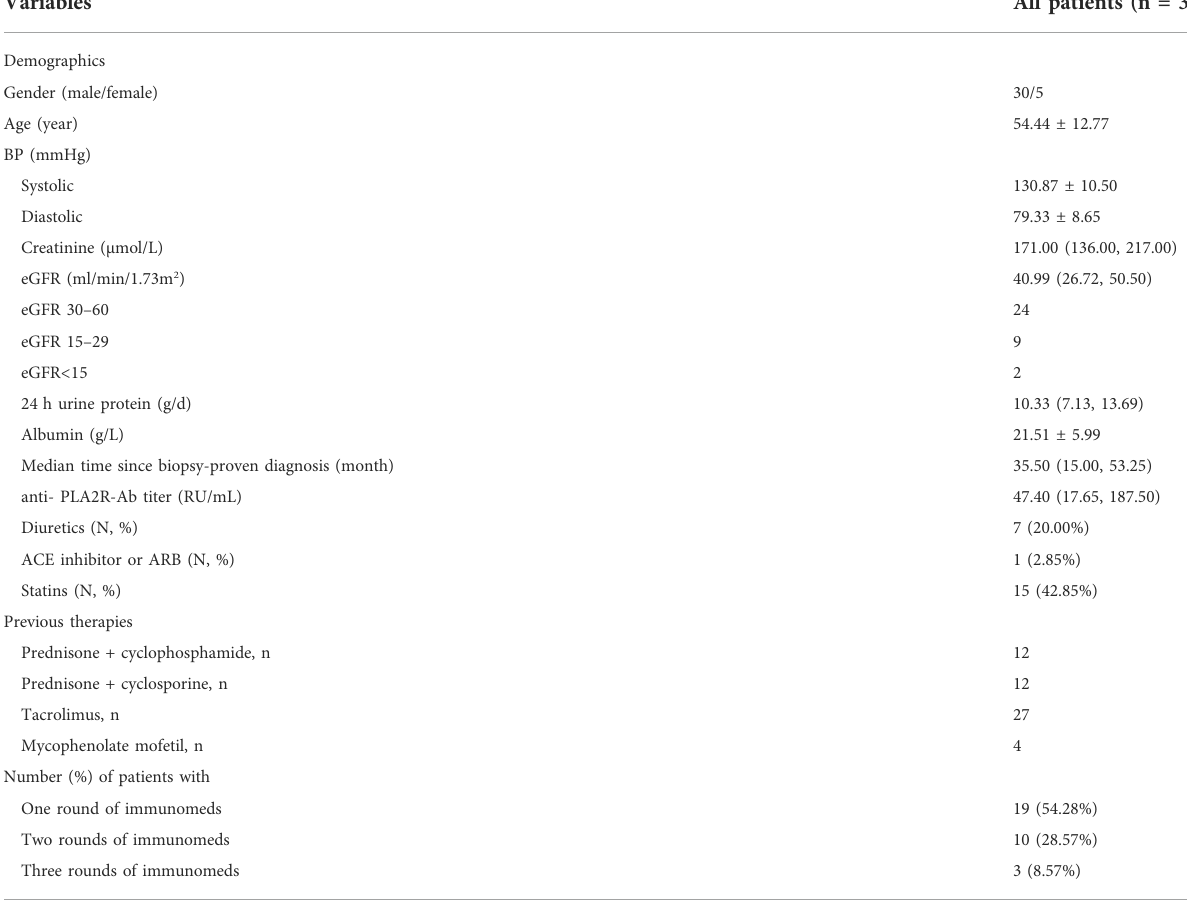
TABLE 1 Baseline characteristics of MN patients with renal insuf fi ciency.